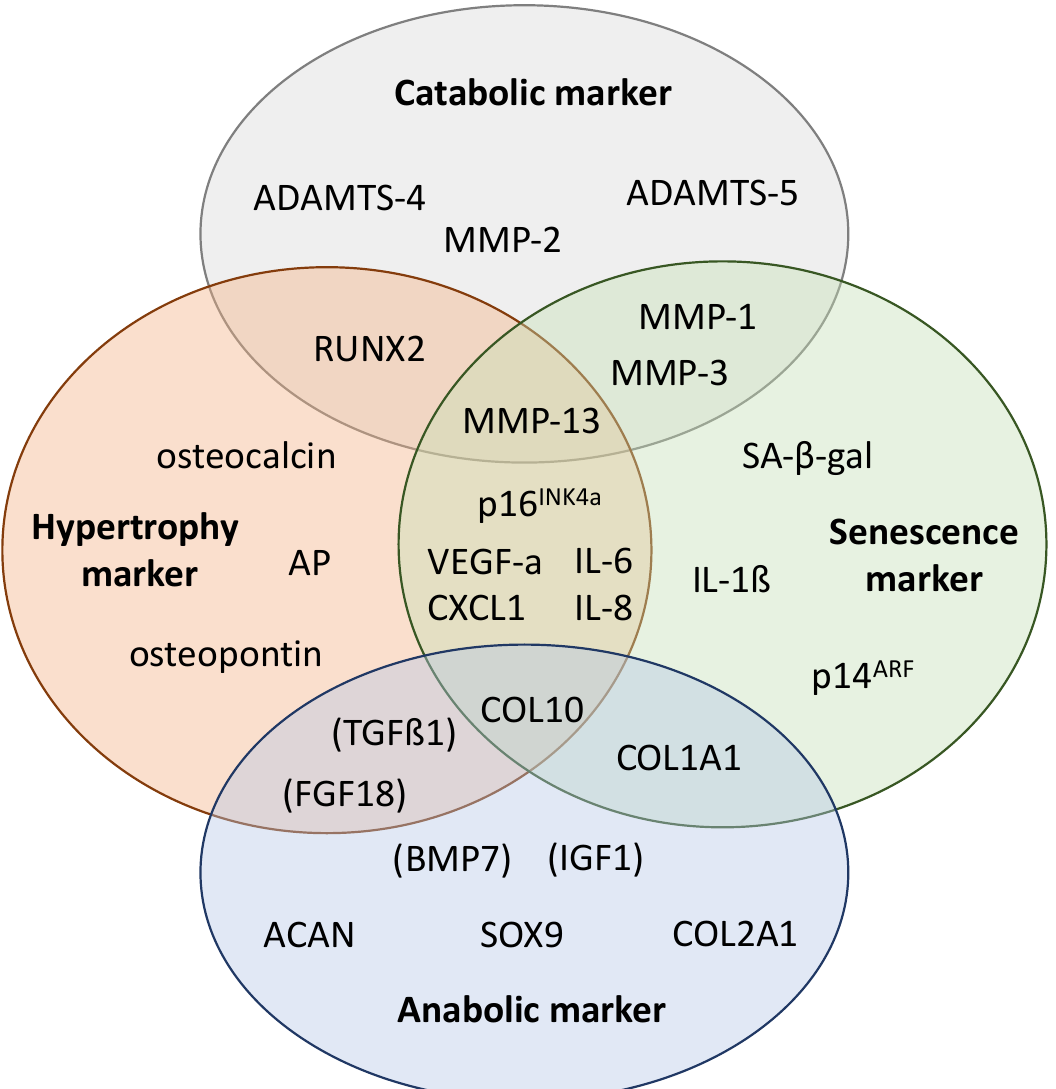
Figure 2. Catabolic, anabolic, hypertrophic and senescence-associated markers in chondrocytes health and